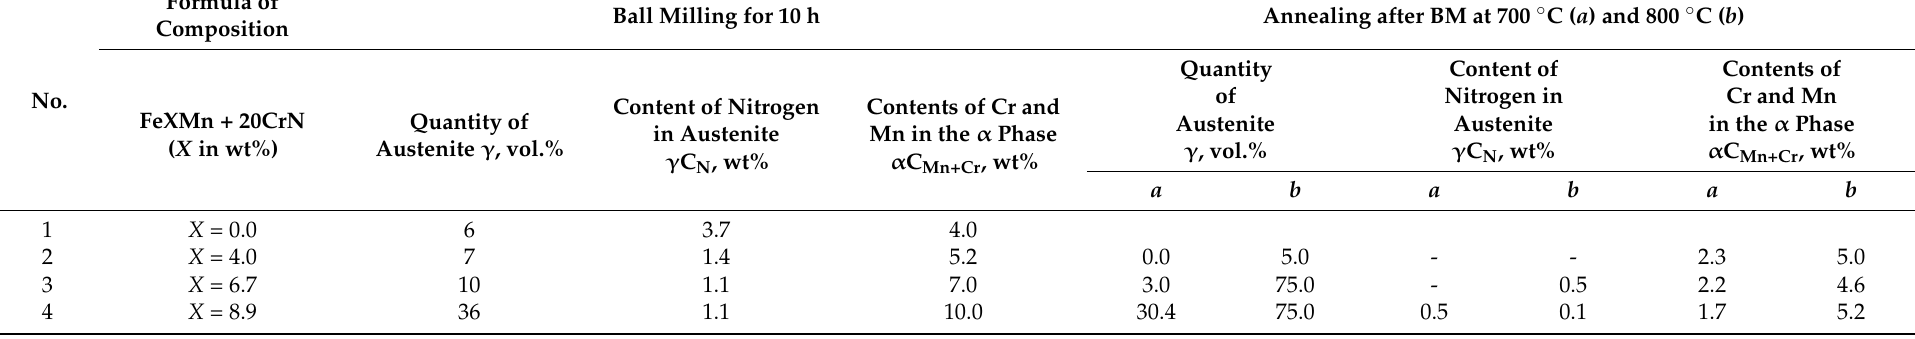
Table 1. The formula of composition, the content of alloying elements, and the quantity of austenite in the mechanical alloying (MA) alloys of series A after the ball milling and subsequent anneals.